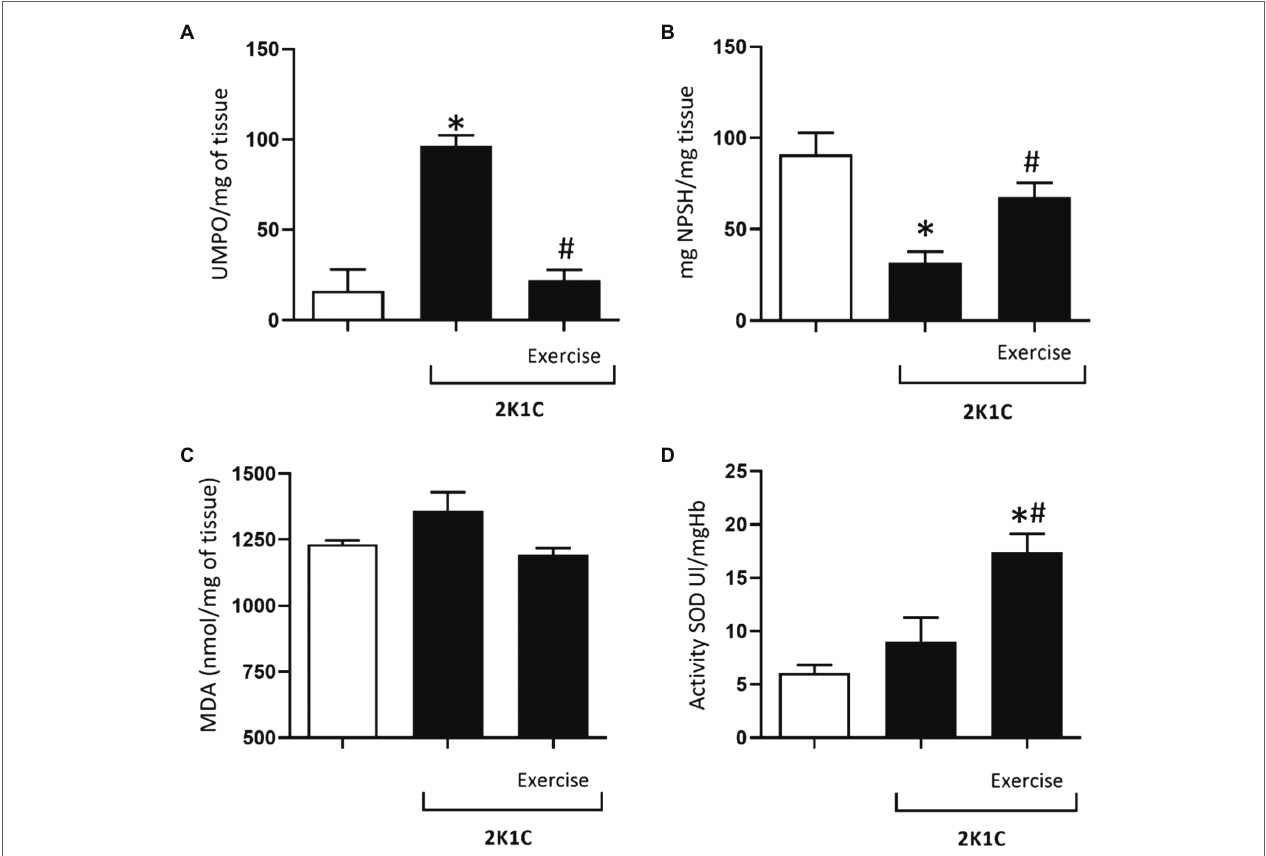
FIGURE 6 | Myeloperoxidase (MPO) activity (A) , glutathione (GSH) concentrations (B) , malondialdehyde (MDA) concentrations (C) , superoxide dismutase (SOD) activity (D) in the duodenum of normotensive and hypertensive 2K1C rats. Experimental Groups: Sham; 2K1C; 2K1C + Exercise. For statistical analysis, mean ± SEM was used, by 2-way ANOVA, followed by Tukey or Kruskal-Wallis test. Significance: p <0.05: * vs. Sham, # vs.